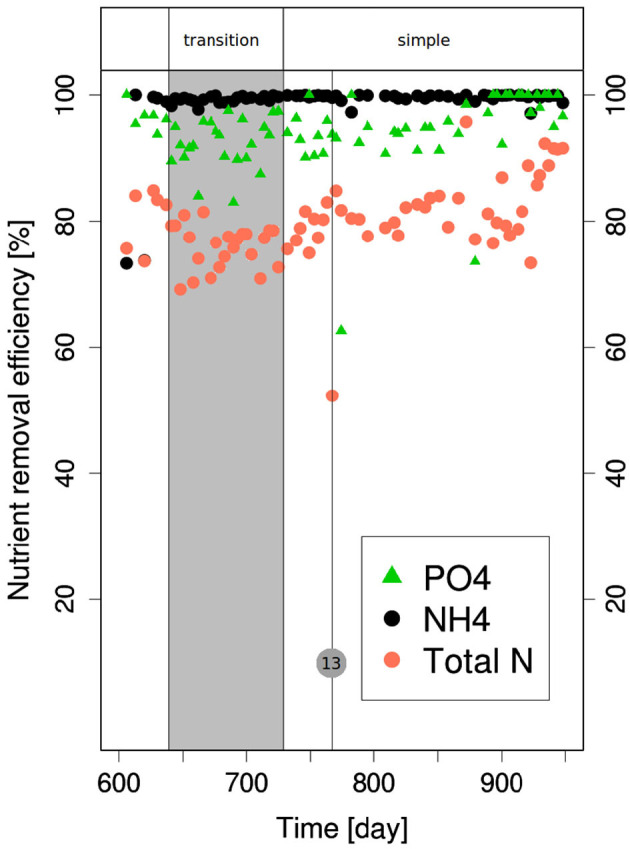
PO4--, NH4-, and TN-removal performances during the transition back from complex monomeric to simple monomeric influent wastewater. The vertical bar with the number (13) corresponds to the day with no feeding during several cycles.